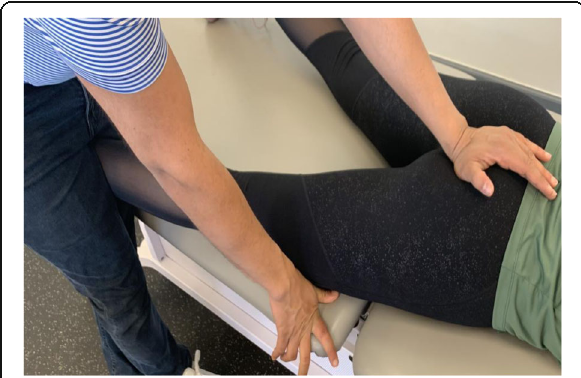
Fig. 1 Long axis distraction. Sacroiliac joint (one person techniques). Hip in abduction, extension, and medial rotation. Pictures taken with verbal and written consent